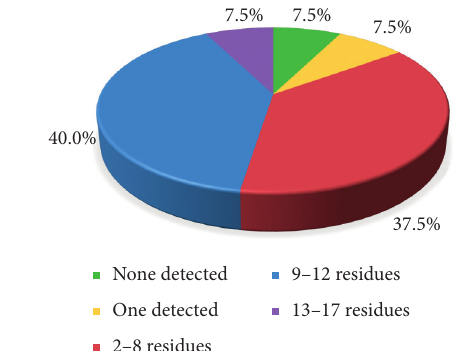
Figure 2: Distribution of detected pesticide residues in analyzed Dendrobium officinale samples.